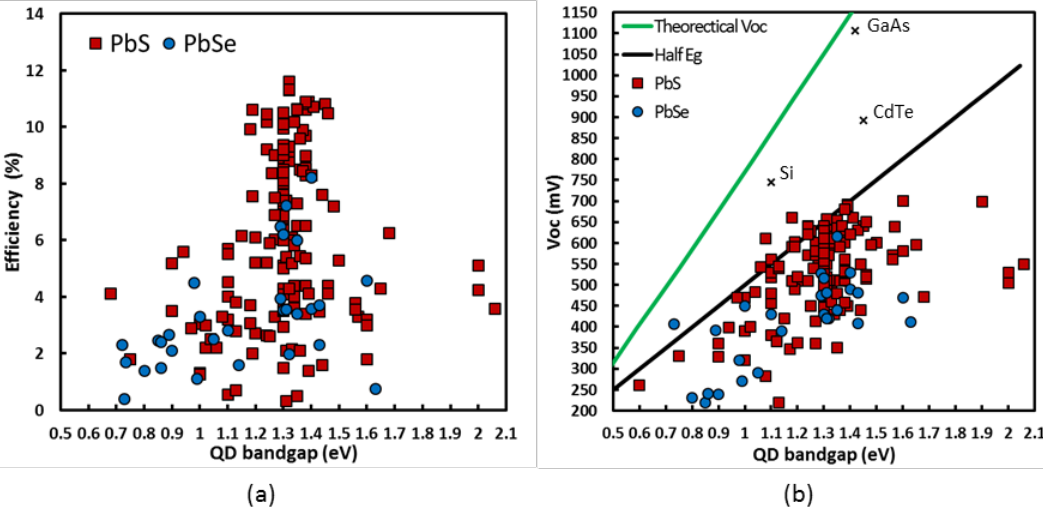
Figure 6. ( a ) The power conversion efficiency of PbS and PbSe QDSCs as a function of QD bandgap reported in the literature (data given in the Supplementary Materials). ( b ) The open circuit voltage (V OC ) of all PbS and PbSe QD solar cells in the literature as a function of band gap with lines showing the theoretical maximum V OC (green) and 1/2 the bandgap (black) highlighting the deficit QD solar cells have compared to Si, GaAs, and CdTe record efficiency solar cells shown with X symbols (data in Supplementary Materials).